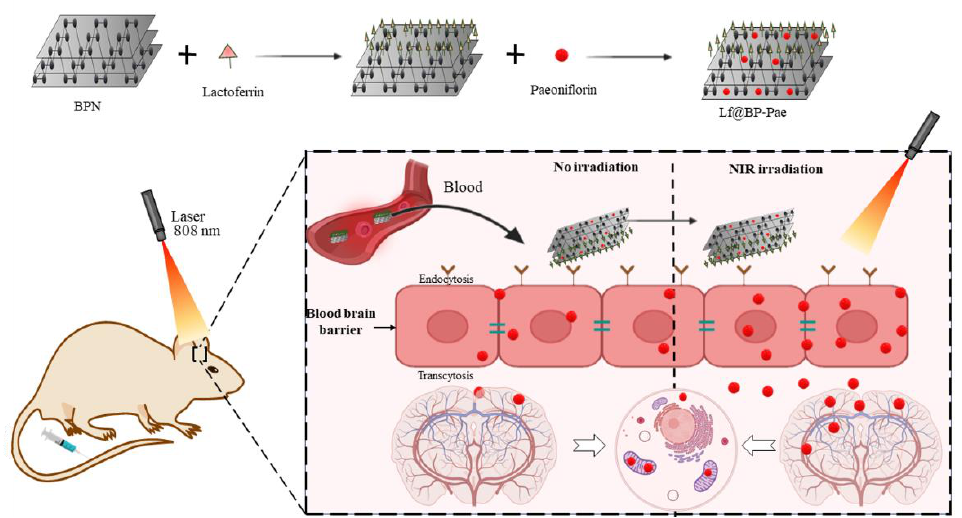
Figure 9. Schematic representation of Lf@BP-Pae synthesis and its therapeutic application in treatment of Parkinson dis- ease.